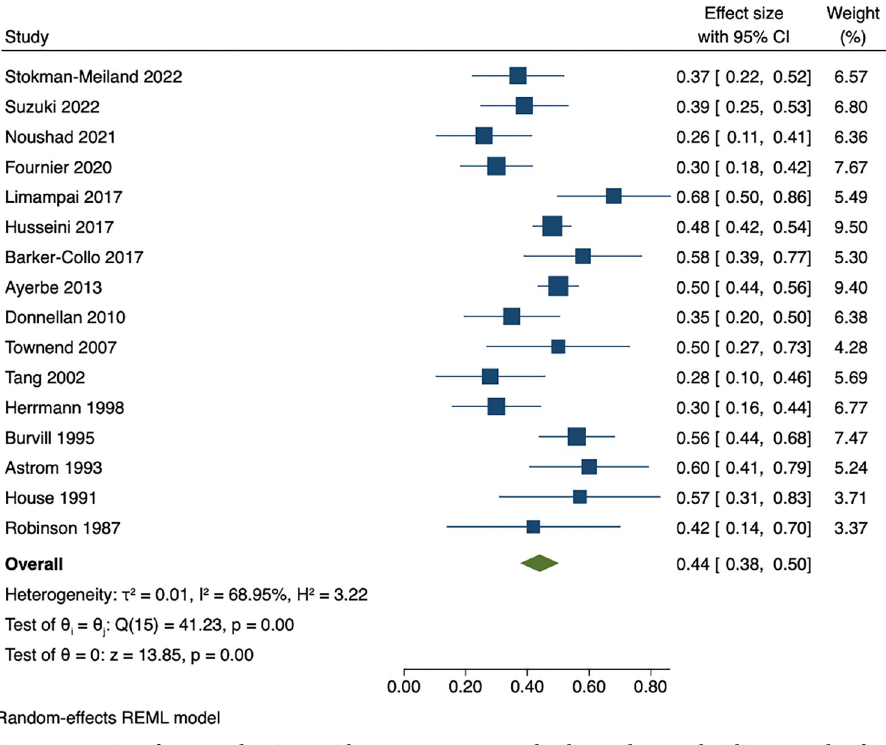
Fig 4. Proportion of recovered patients within 1 year among people who are depressed within 3 months after stroke.